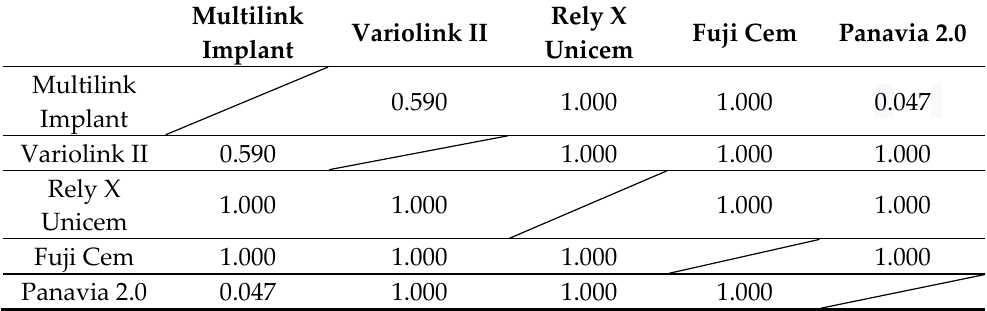
Table A2. Comparison of the different adhesives during the pull-off test: Ivoclar Empress CAD.